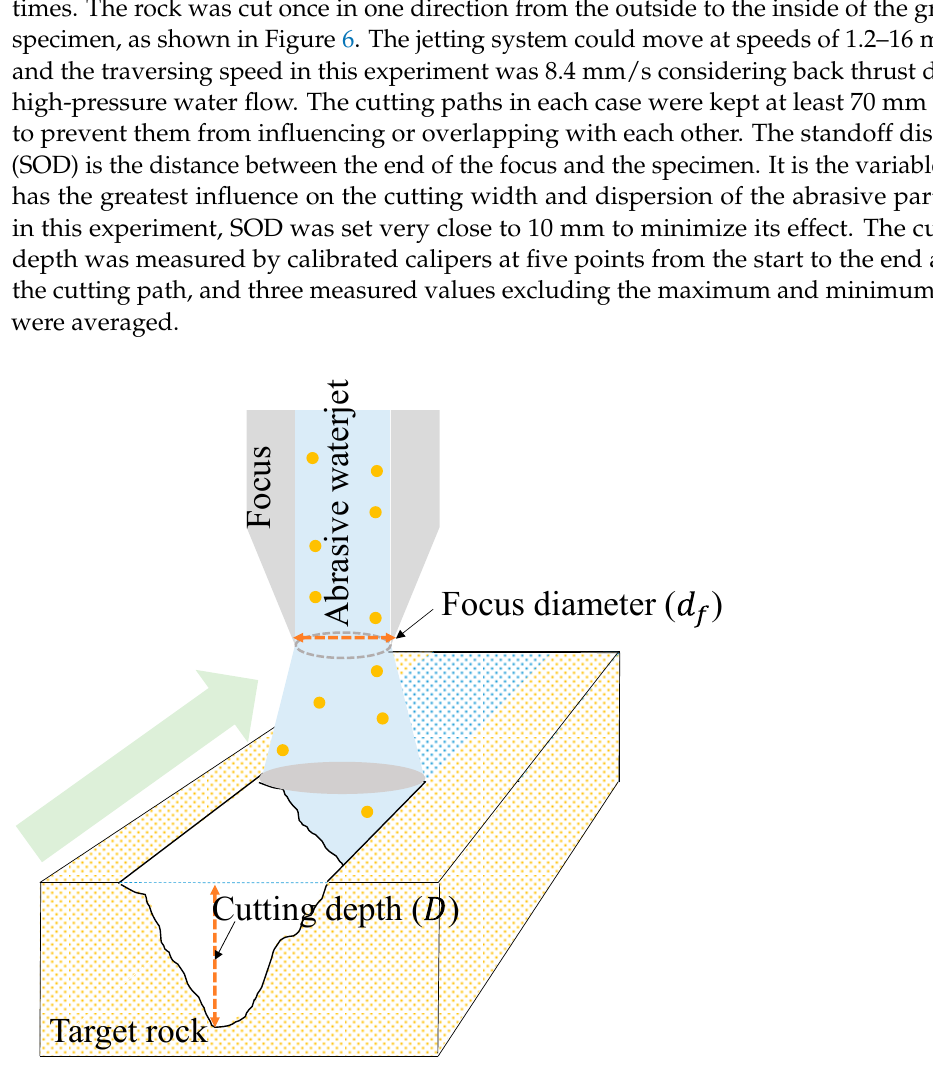
8 of 15 Table 4. Granite specimen properties. UCS (MPa) Shear Strength (MPa)